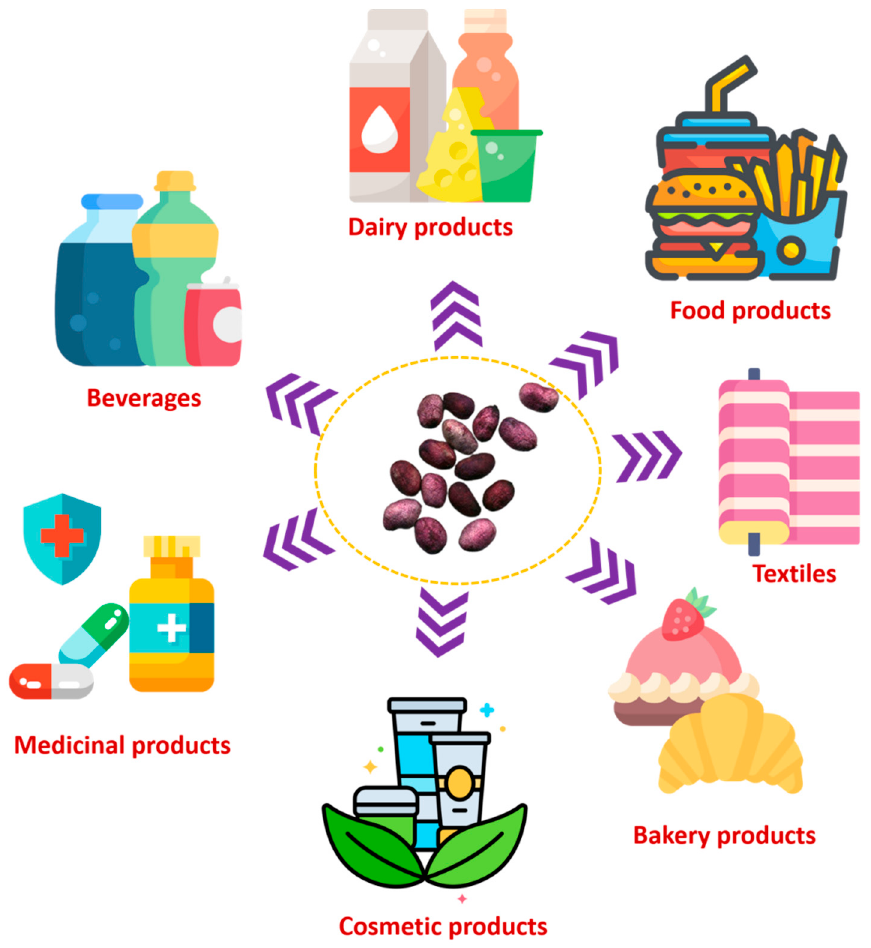
Figure 2. Applications of jamun seed powder as used in food products, beverages, bakery products, cosmetic products, dairy products, medicinal products, and in textiles.